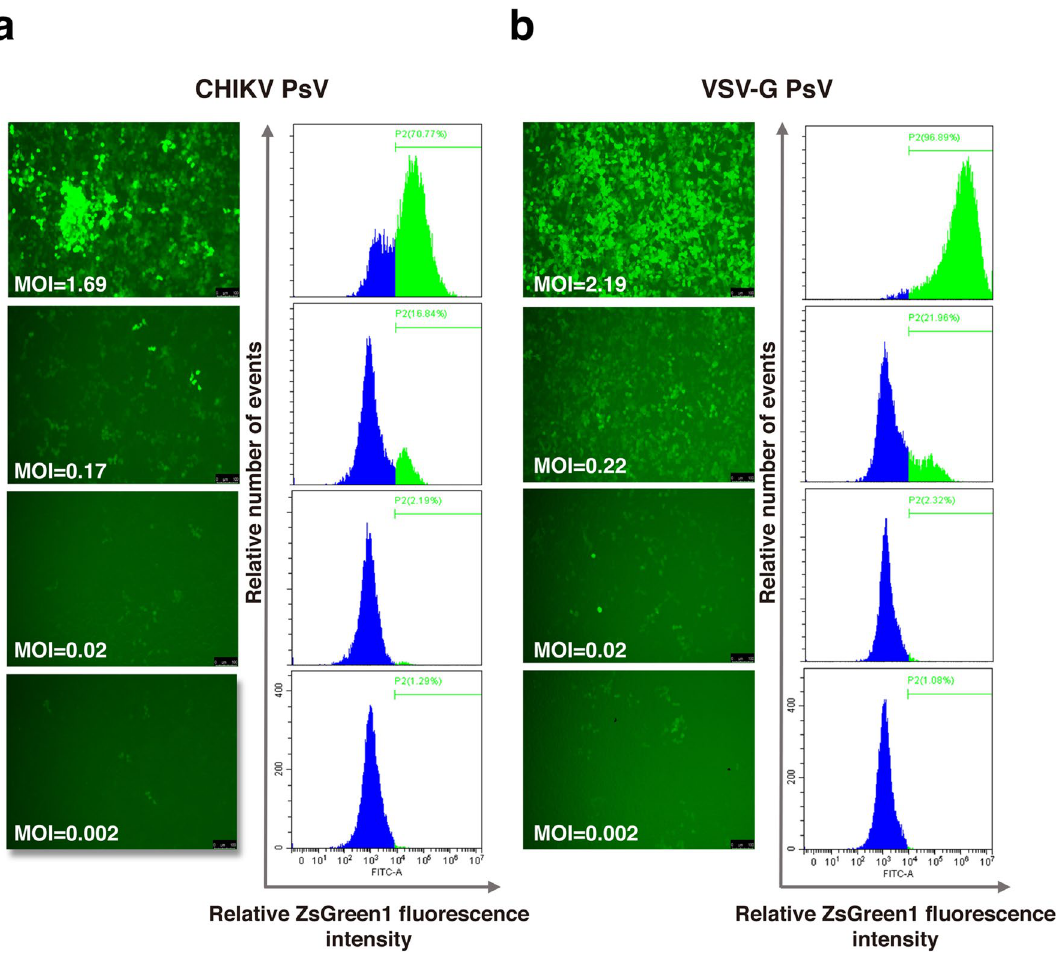
Figure 3. Titration of the CHIKV PsV. 293T cells in the 24-well plate were transduced with serial ten-fold dilutions of PsV particles ( a ) or VSV-G PsV ( b ). At 72 h post transduction, cells were firstly observed under the fluorescence microscope (left panel). Then cells were trypsinized and resuspended for titration via flow cytometric analysis (right panel). Panels in this figure from top to bottom correspond to 1–1000 times dilutions. The MOI was calculated for 293T cells in each well according to the PsV titer. Scale bar: 100